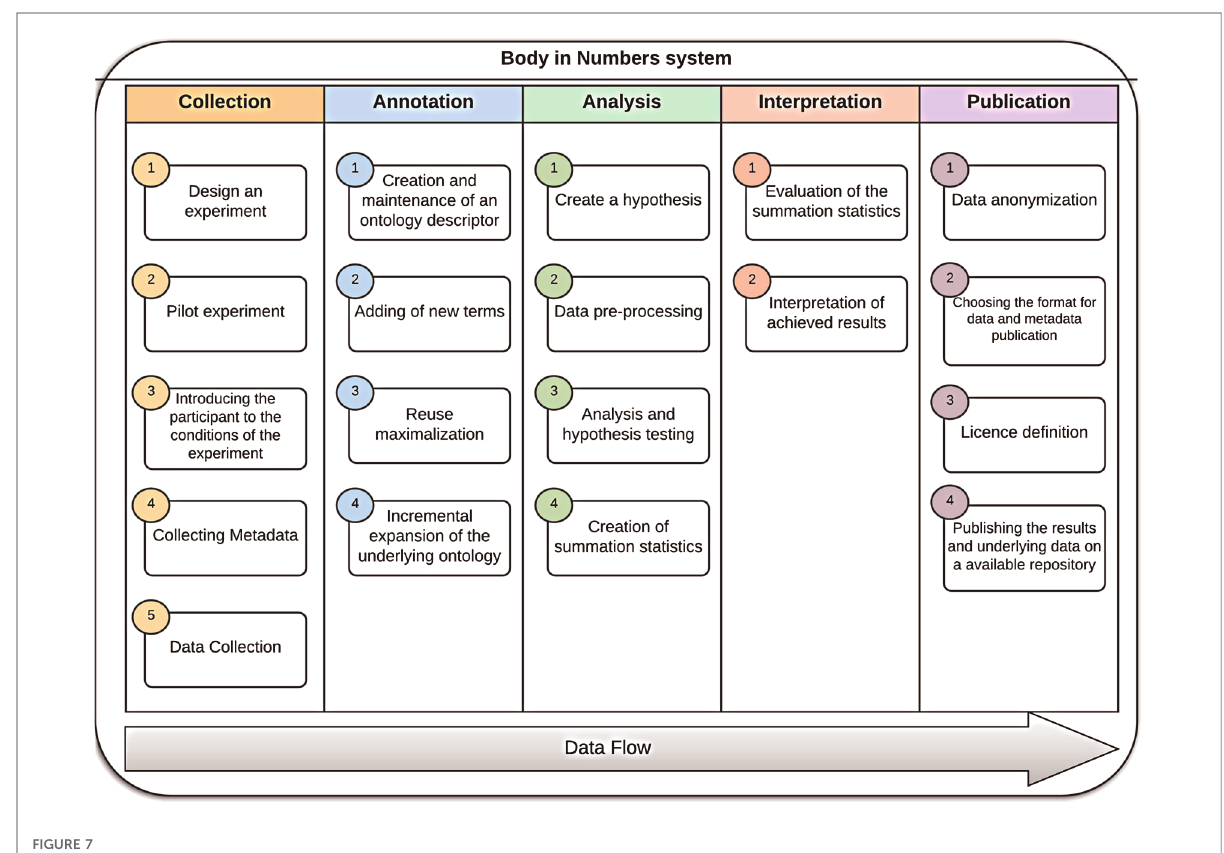
FIGURE 7 Data fl ow – layer